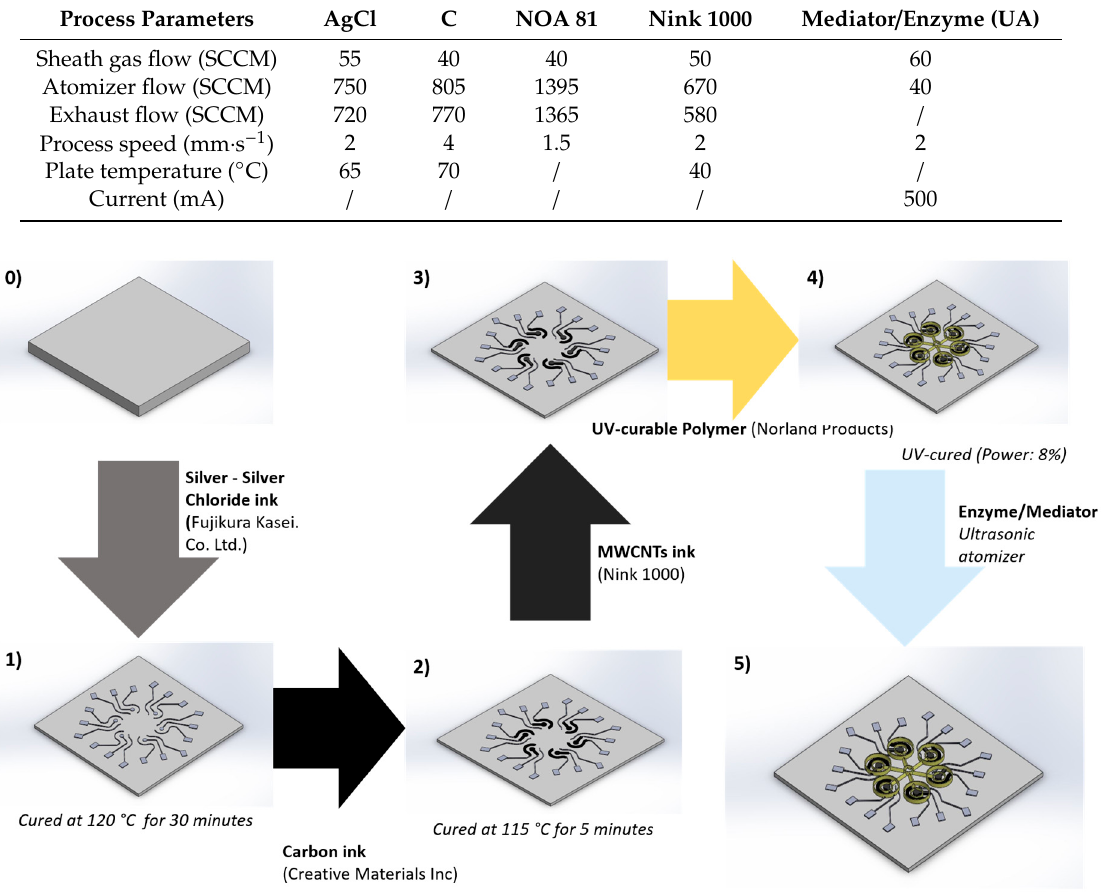
Figure 3. AJP process for microfluidic sensors platform fabrication.